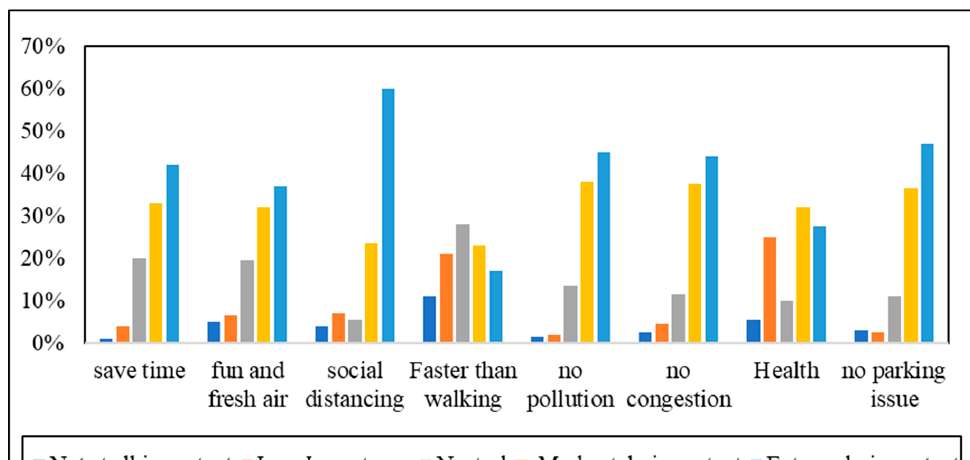
Figure 5. Participants’ perceptions about the advantages/benefits of using SFFESs.